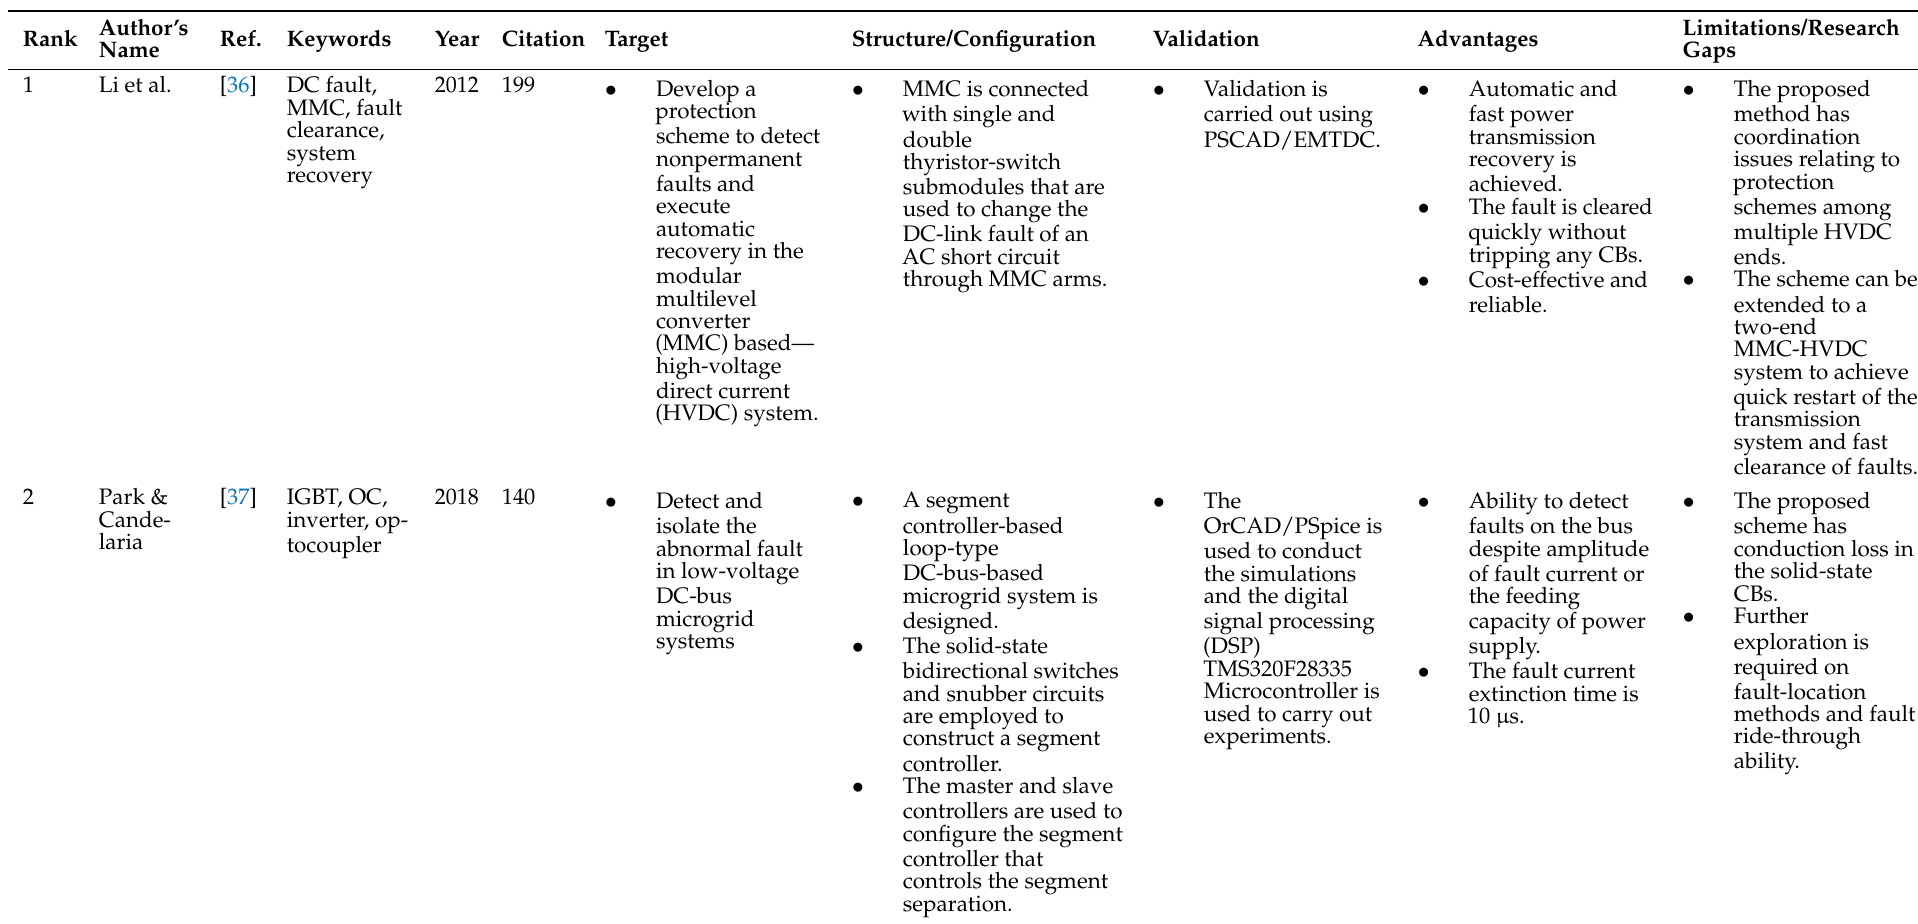
Table 2. Summary of top ten articles based on the highest citation in the past 5